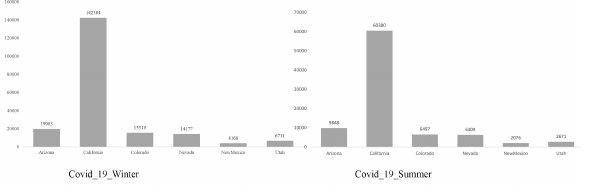
Figure 6. Bar plot diagram for infected by Covid-19